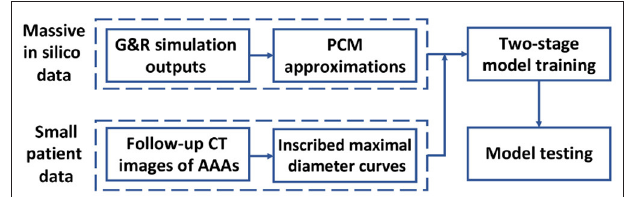
FIGURE 1 | Diagram of overall methodology. A massive number of in silico data and a small number of patient data are generated and processed, respectively, which is followed by a two-stage model training and a model